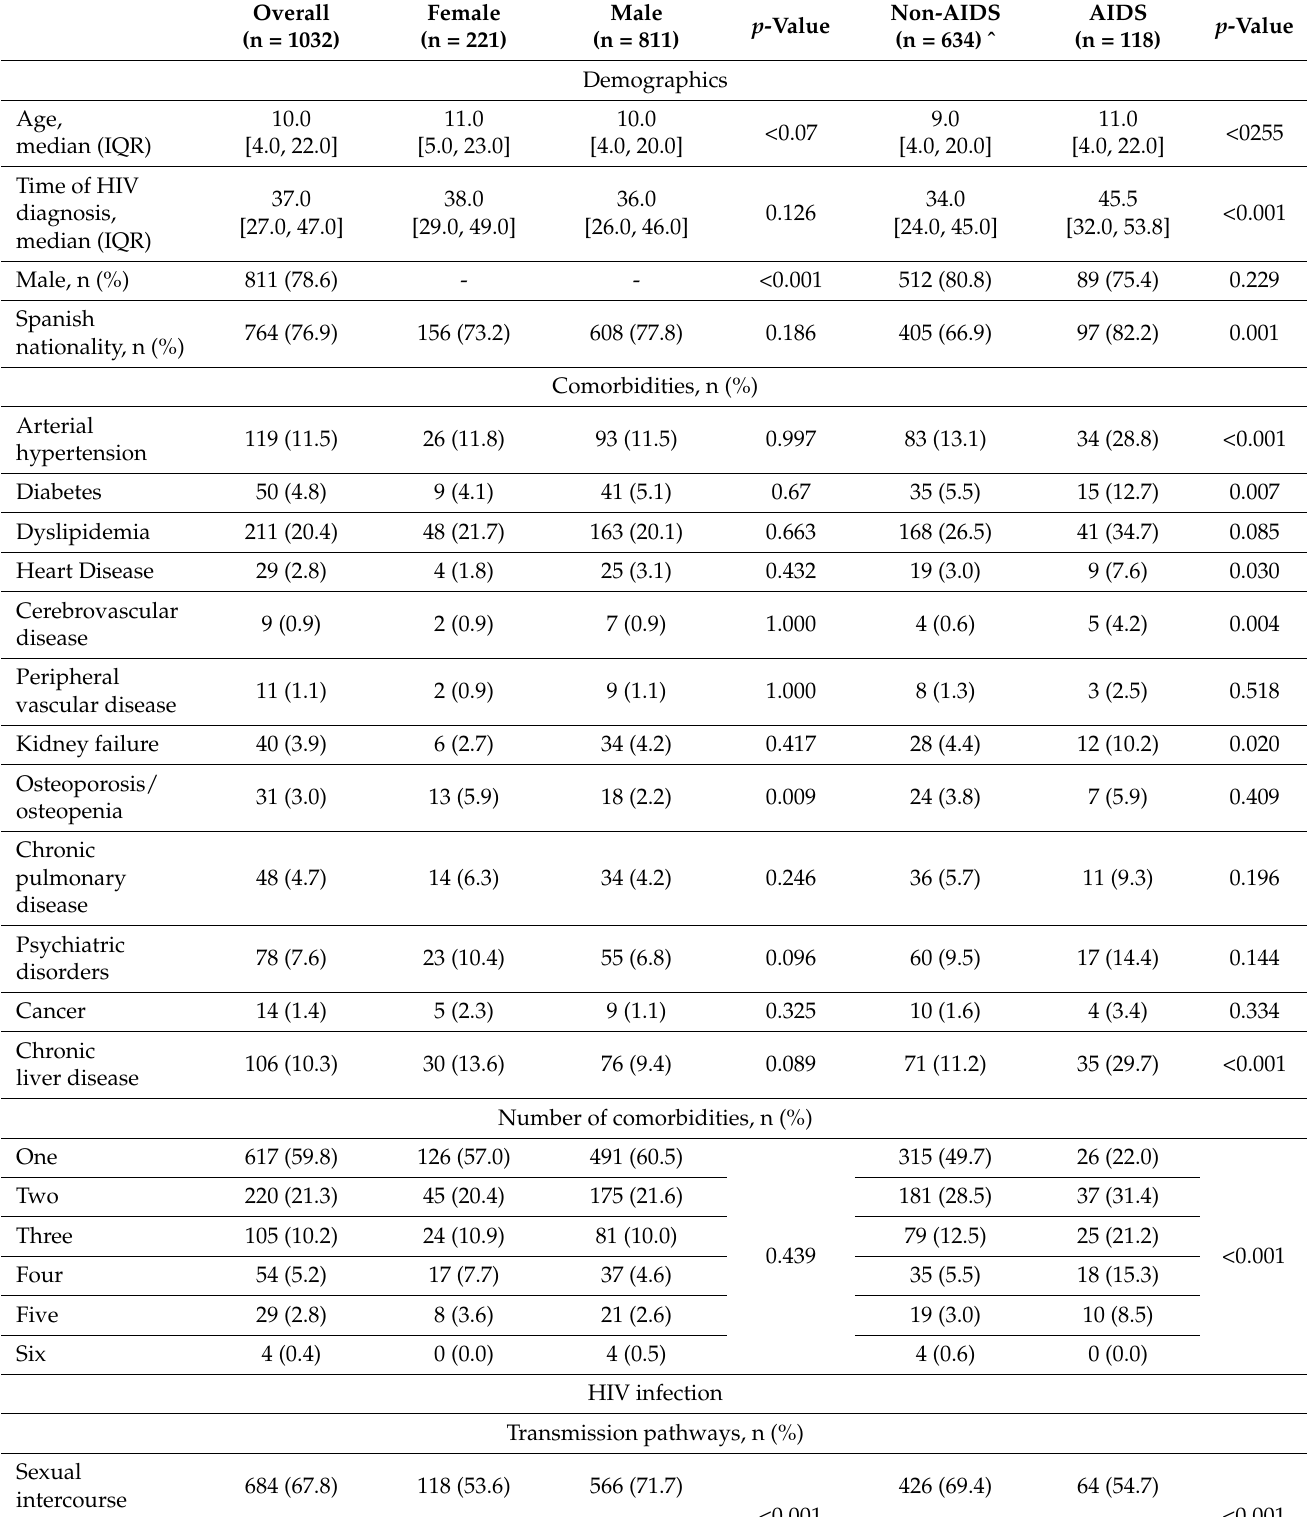
Table 1. Main characteristics of PLWHIV treated with DTG + 3TC in the SPADE